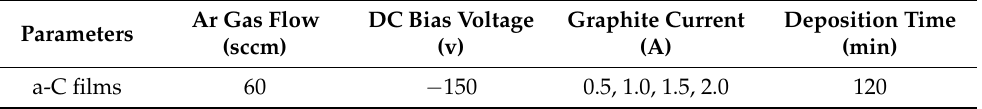
Table 1. Depositing parameters for the a-C